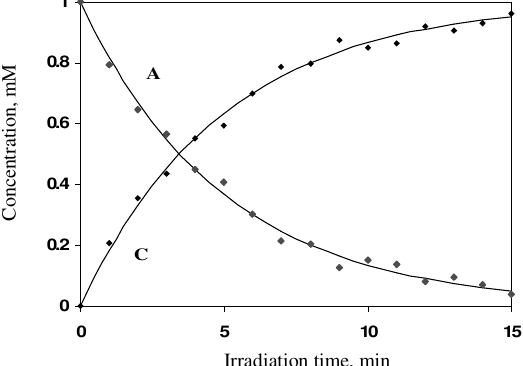
Figure 4. The pure absorption spectra of EE (A), EZ or ZE (B), ZZ (C) isomers of BDAE in chloroform